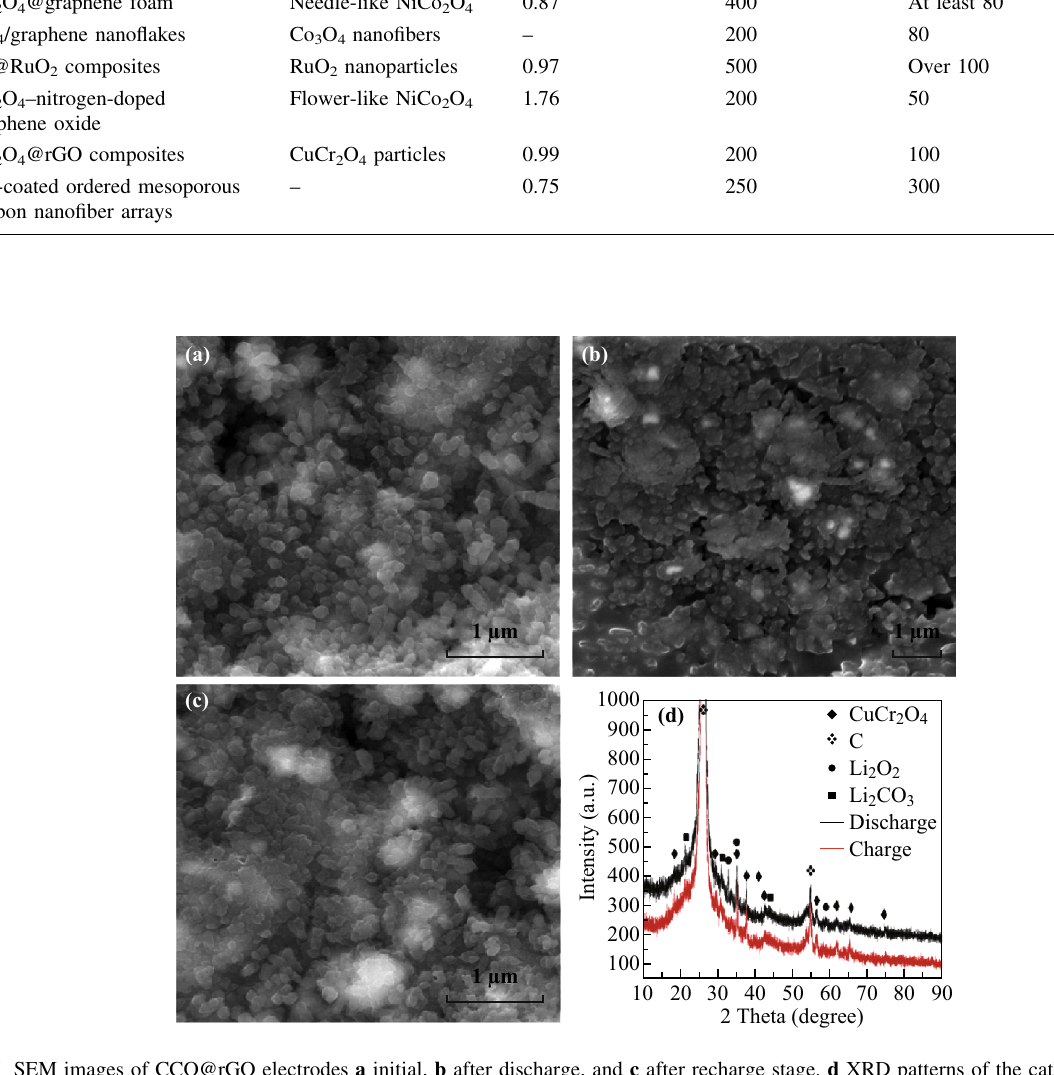
Fig. 5 SEM images of CCO@rGO electrodes a initial, b after discharge, and c after recharge stage. d XRD patterns of the cathodes after the discharge and recharge